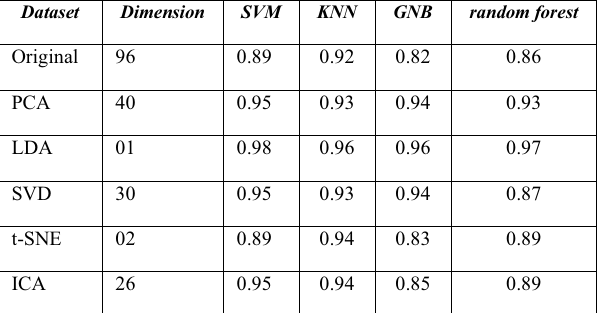
Table 5. Classification performance of original and